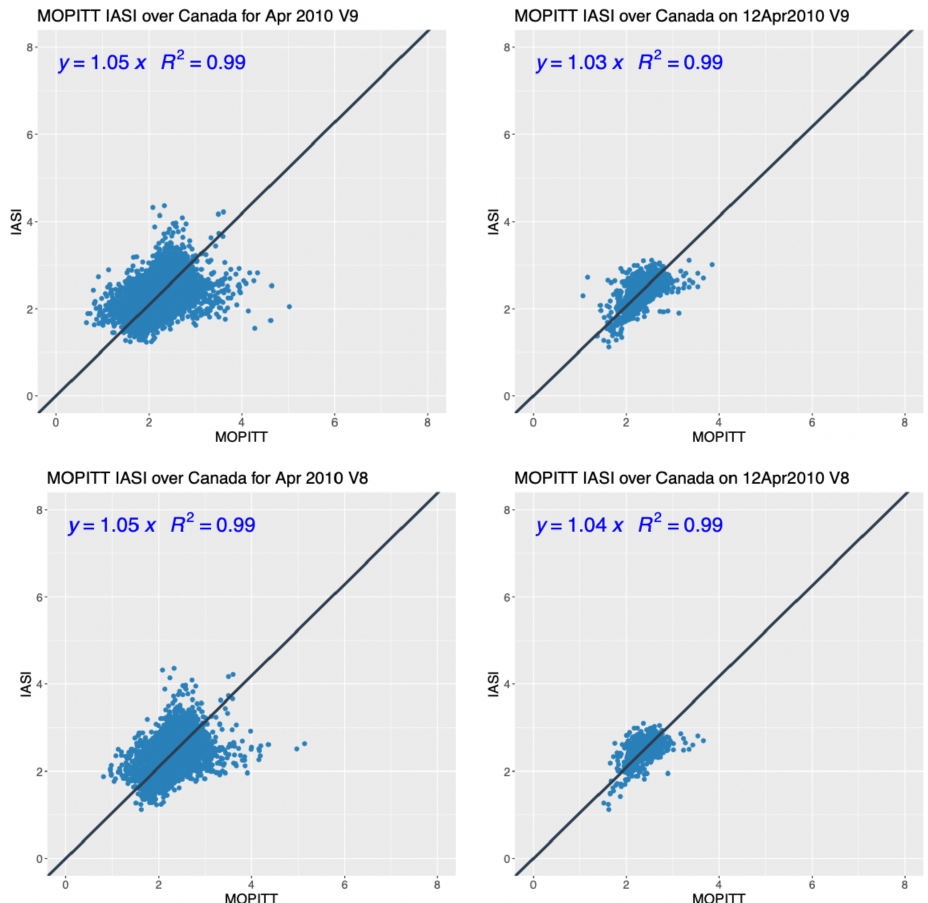
Figure 13. The same as Fig. 11 but for 12 April